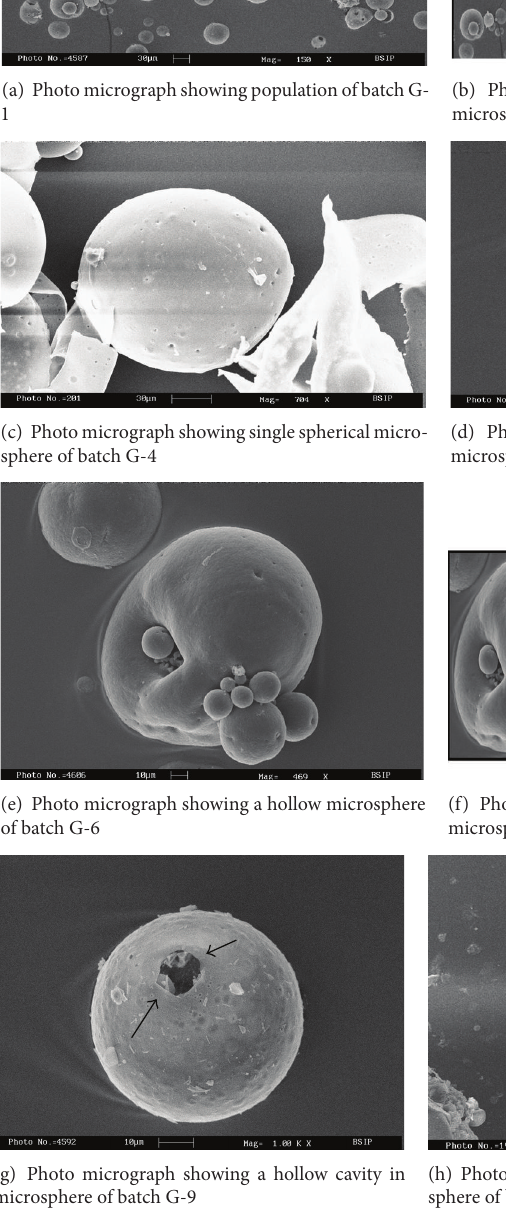
Figure 2: Scanning electron micrograph of floating hollow